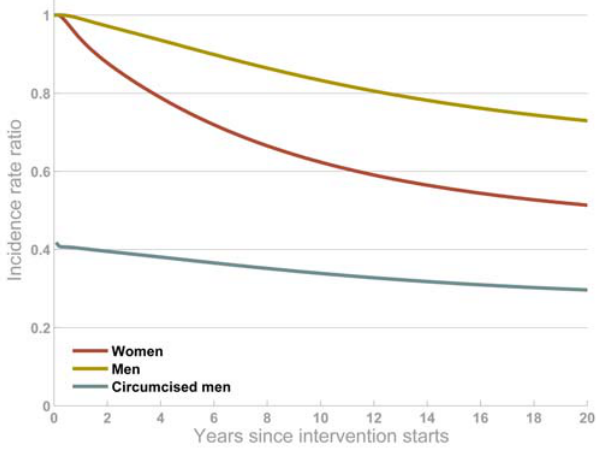
Figure 2. Impact of the intervention among women (red line), uncircumcised men (yellow line) and circumcised men (blue line) (90% circumcision coverage achieved). The output is the ratio of HIV incidence when the intervention is simulated relative to the projection with no intervention. In these simulations, the operation wound is assumed to heal